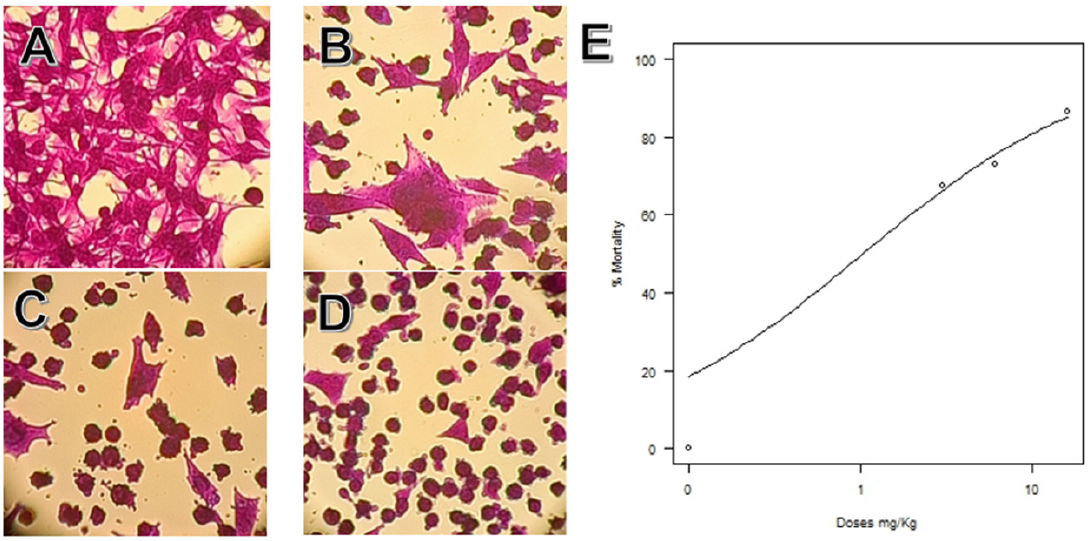
Figure 7. Sulforhodamine’s cell growth test of B16F1 cells exposed to different doses of NCTD. Micrographs (40×) of ( A ) control group, ( B ) 3 mg/kg, ( C ) 6 mg/kg, ( D ) 16 mg/kg; ( E ) graphic representation of the Log-logistic model fit of the IC50 and % of cell mortality. Plot data: For slope: − 0.637, S.E.: 0.135, t-value: − 4.69 ( p < 0.001); and for the IC50 intersection: 1.026, S.E. 0.370, t-value 2.76 *; residual std error 6.44 and 22 degrees of freedom ( p < 0.01).